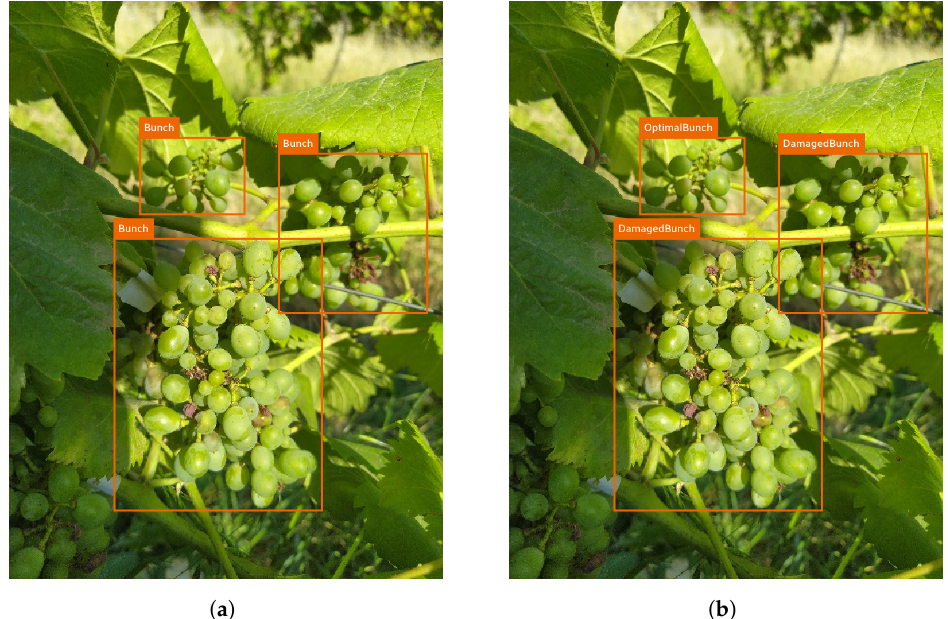
Figure 2. Examples of annotations from each dataset. ( a ) Grapevine Bunch Detection Dataset. ( b ) Grapevine Bunch Condition Detection